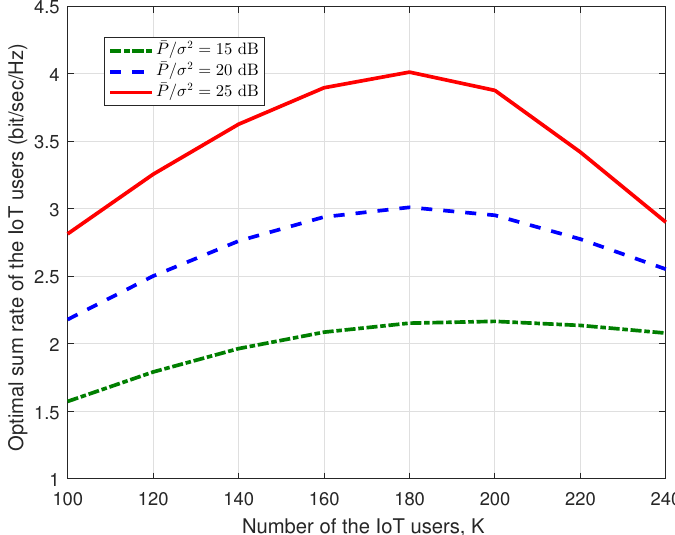
Figure 8. Optimal sum rate of the IoT users vs. the number of the IoT